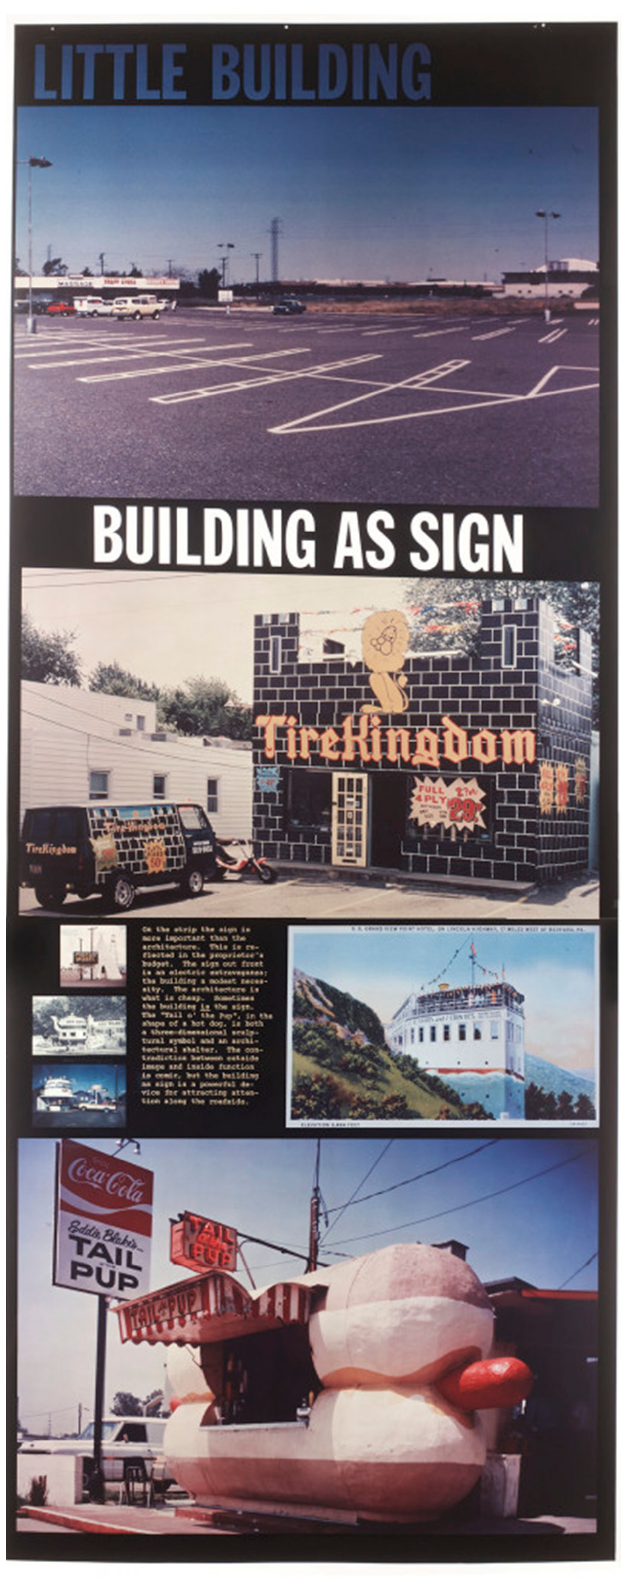
Figure 6. Robert Venturi, John Rauch, and Denise Scott Brown, Architects and Planners, Signs of Life: Symbols in the American City Renwick Gallery , Washington D.C. 1974–1976. Building as sign exhibit panel. Credit Line: Venturi, Scott Brown Collection, The Architectural Archives, University of Pennsylvania.